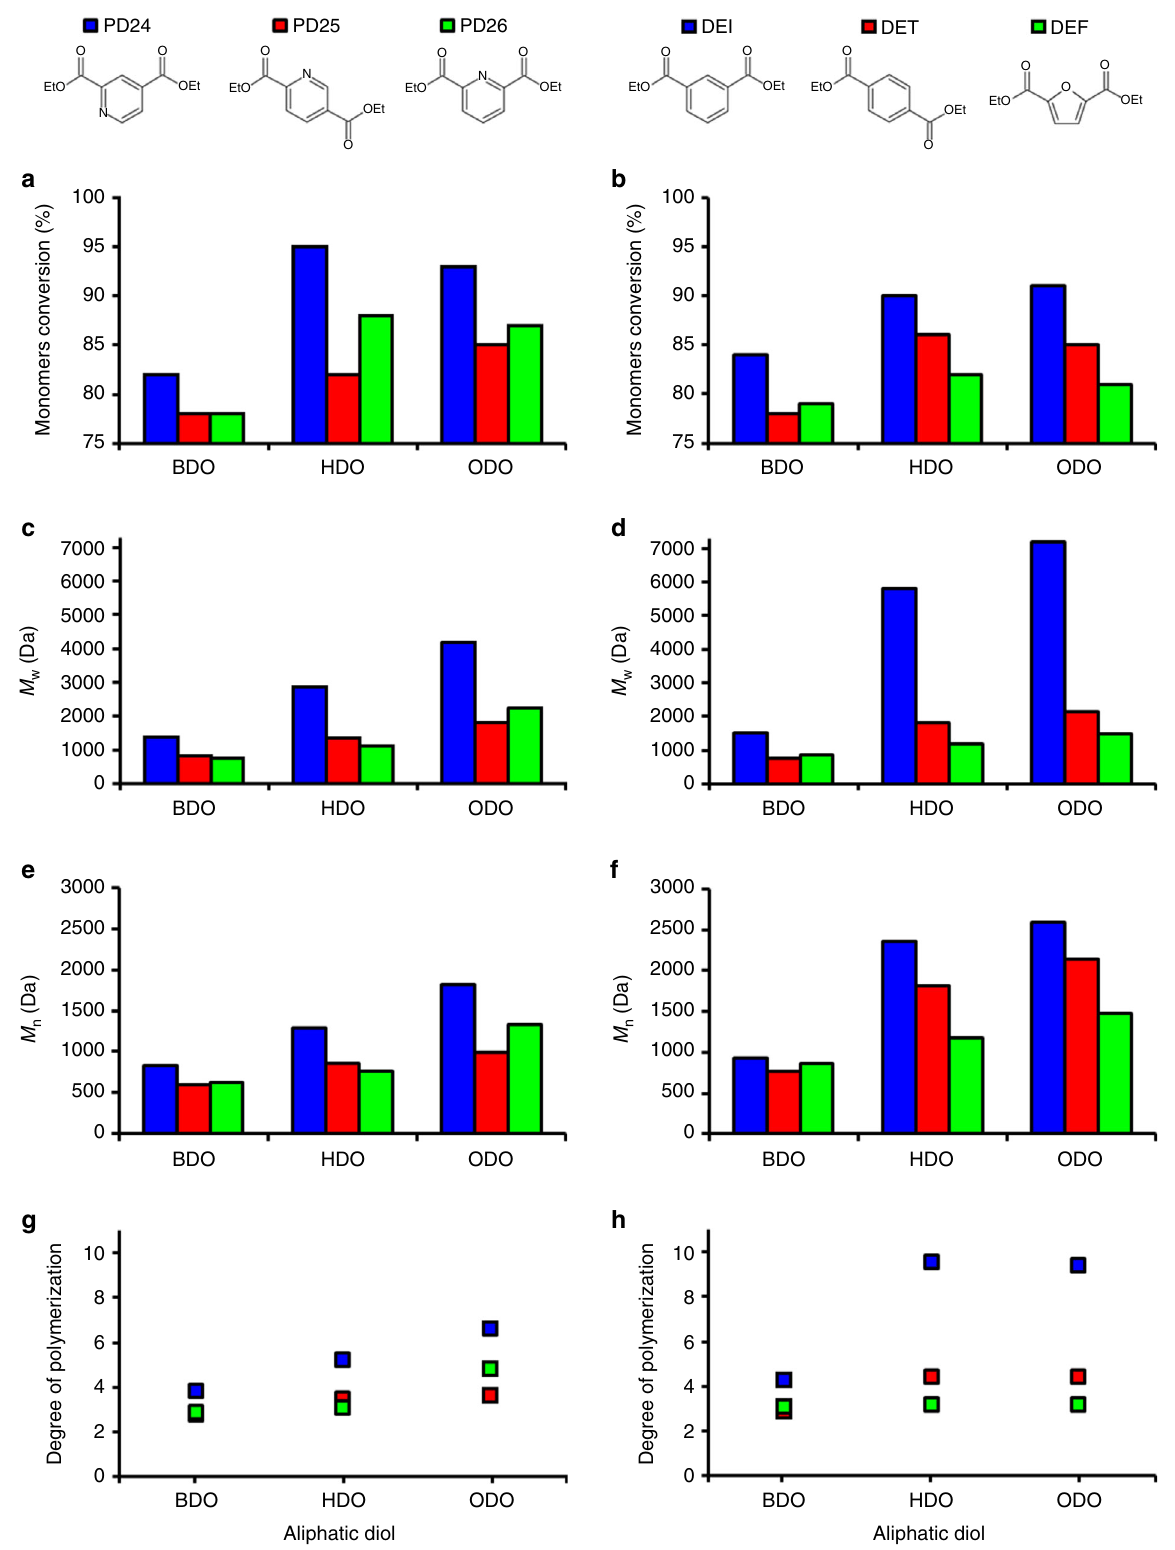
Fig. 2 Enzymatic synthesis of pyridine-based polyesters in a solventless reaction system. a , b Monomers conversion calculated via 1 H-NMR